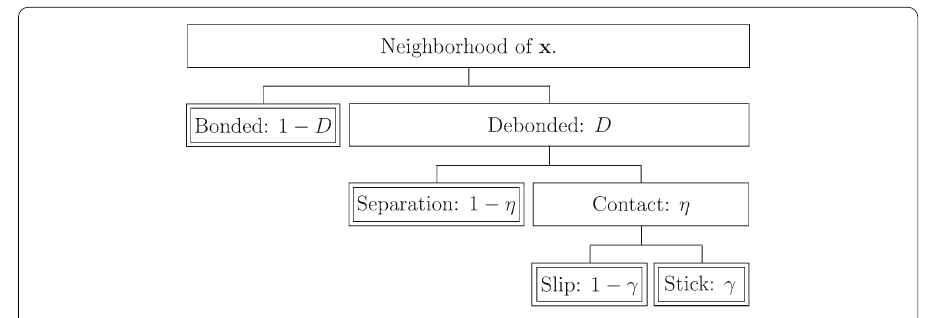
Fig. 1 Hierarchy of subscale interface states in the in the neighborhood of macroscopic location, x , and partition-of-unity interpolation functions. The set of basic interface states, S , comprises the four highlighted leaf nodes in the